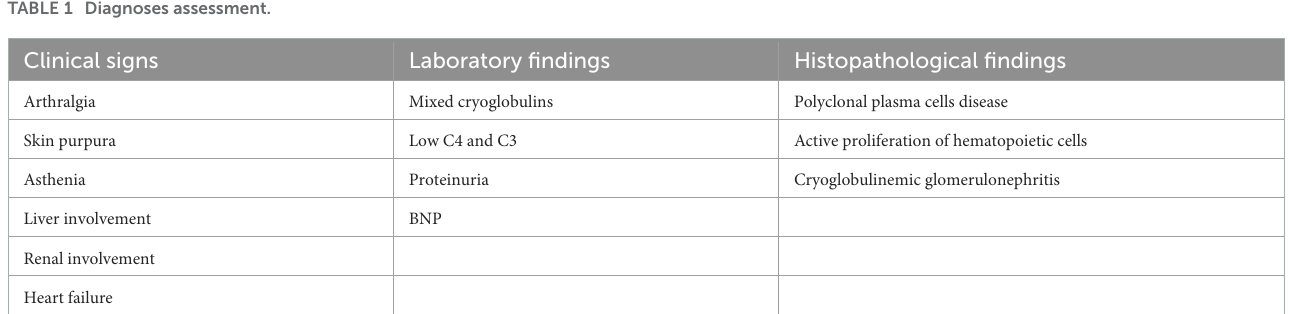
TABLE 1 Diagnoses